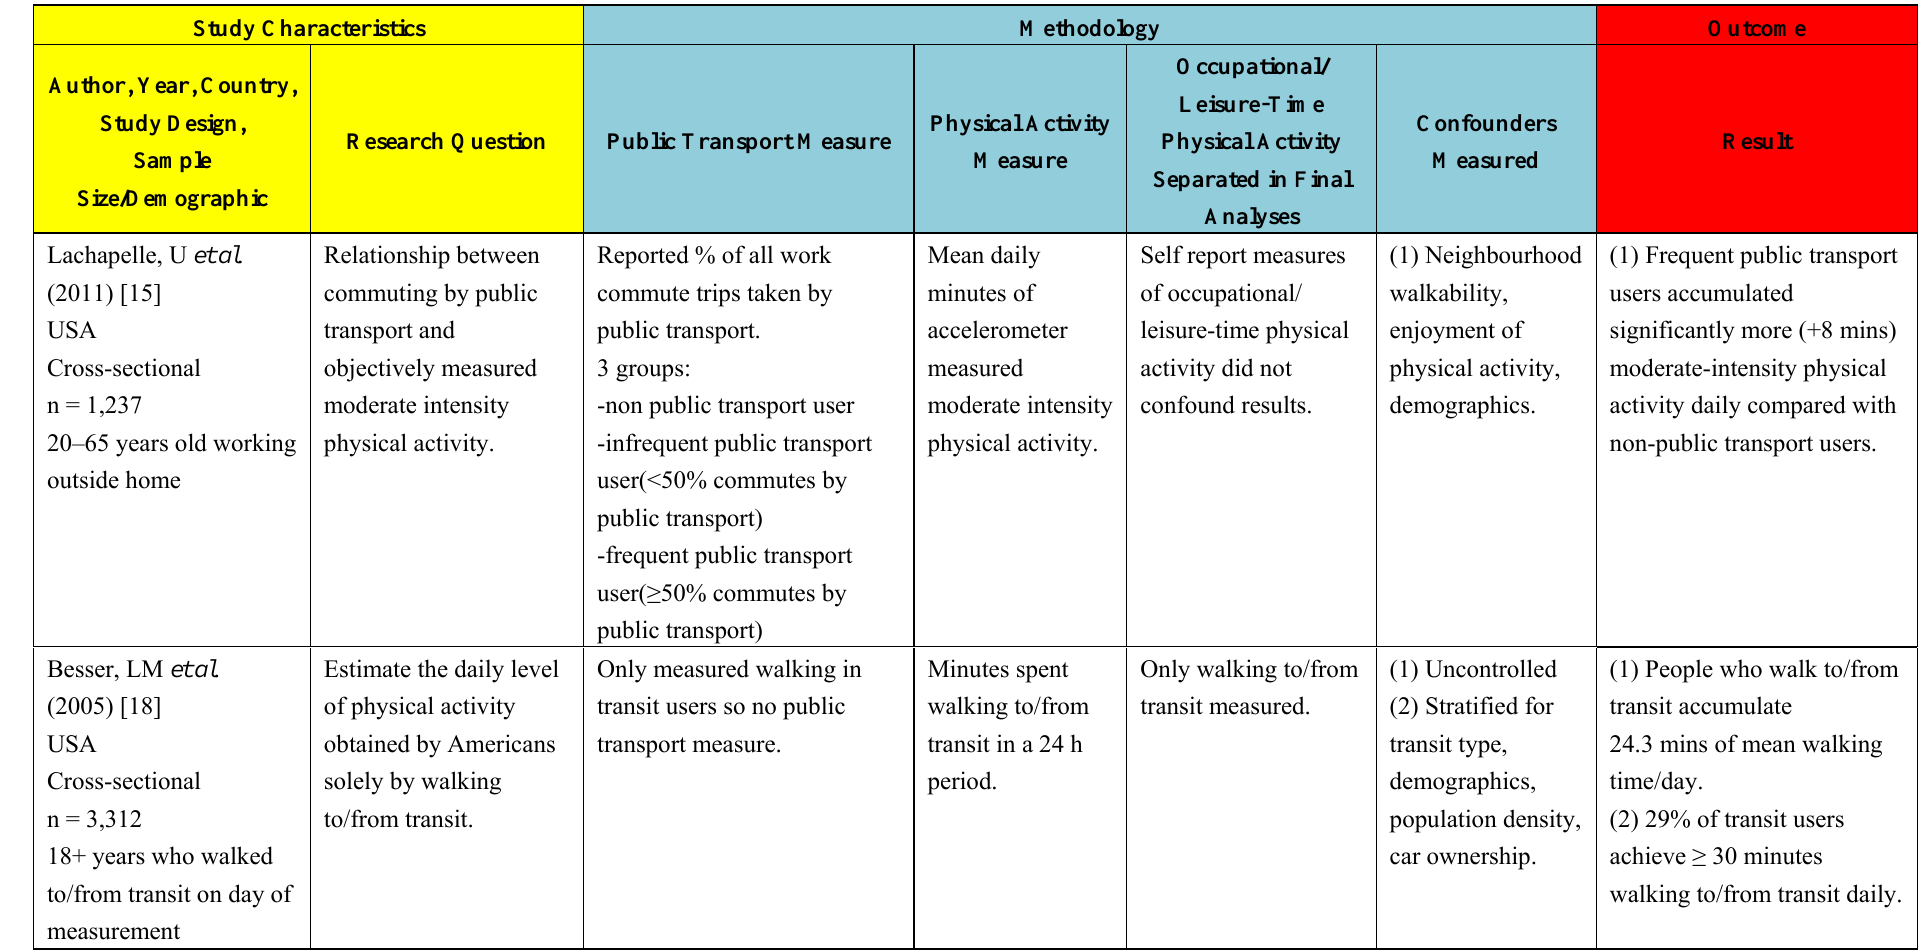
Table 2. Studies reporting objectively measured physical activity in adults in relation to public transport